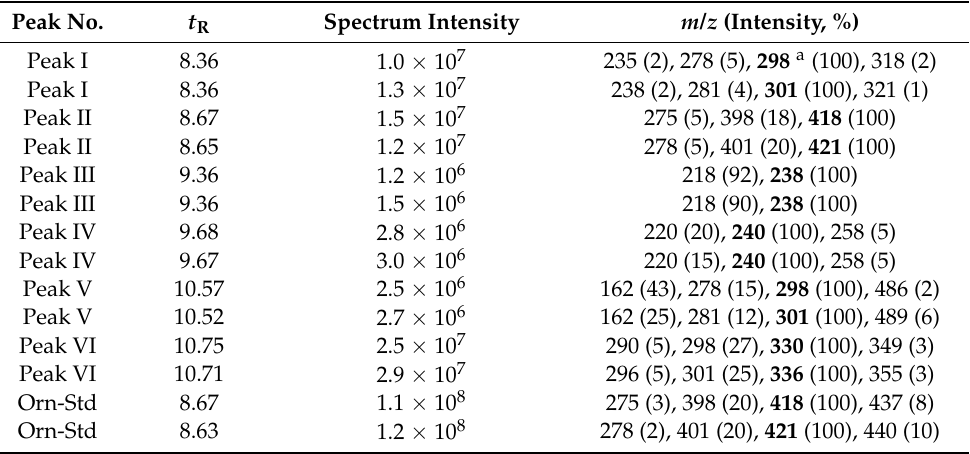
Table 1. GC-MS retention times ( t R , min) and most intense ions in the mass spectra of the six reaction products of citrulline derivatized with procedure B (first PFPA/EA then 2 M HCl/CH 3 OH or 2 M HCl/CD 3 OD). For comparison, synthetic ornithine standard (Orn-Std) was also derivatized with procedure B. See also Figure